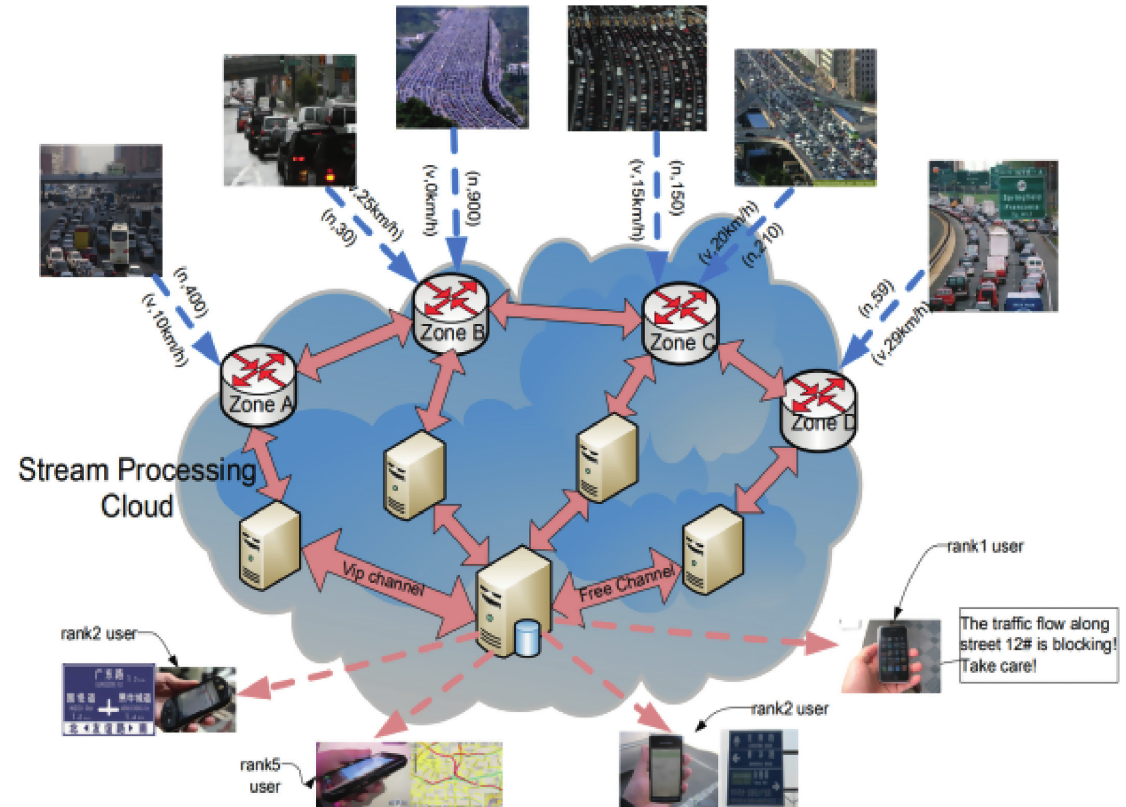
Figure 1: An illustration of the online traffic data analysis system used in Example